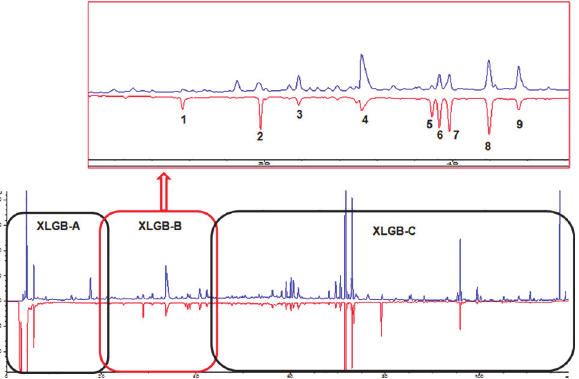
Fig 2. HPLC fingerprint chromatograms of XLGB extract. The blue line is the fingerprint of UV detector and the red line is the one of ELSD. Three fractions (XLGB-A, B, C) were indicated in the square, and the XLGB-B part was amplified in the upper right square. Names of the peaks (1 – 9) were listed in Table 5. 2 at 0.01 μ M and Compound 6 at 1 μ M from Radix Dipsaci also significantly increased cell pro- liferation ( P < 0.05 for both). While Compounds 8 and 9 from Fructus Psoraleae had no effects on UMR 106 cell proliferation at the selected doses. Fig. 3 showed the effect of the nine com- pounds and the negative control on the mineralization of UMR 106 cells using Alizarin Red S for staining calcium nodules. Compounds 2, 5 and 6 from Radix Dipsaci and Compounds 8 and 9 from Fructus Psoraleae obviously promoted mineralization. Compounds 5 and 6 from Radix Dipsaci and 7 from Herba Epimedii significantly inhibited the formation of adipocytes ( P < 0.05 for both).